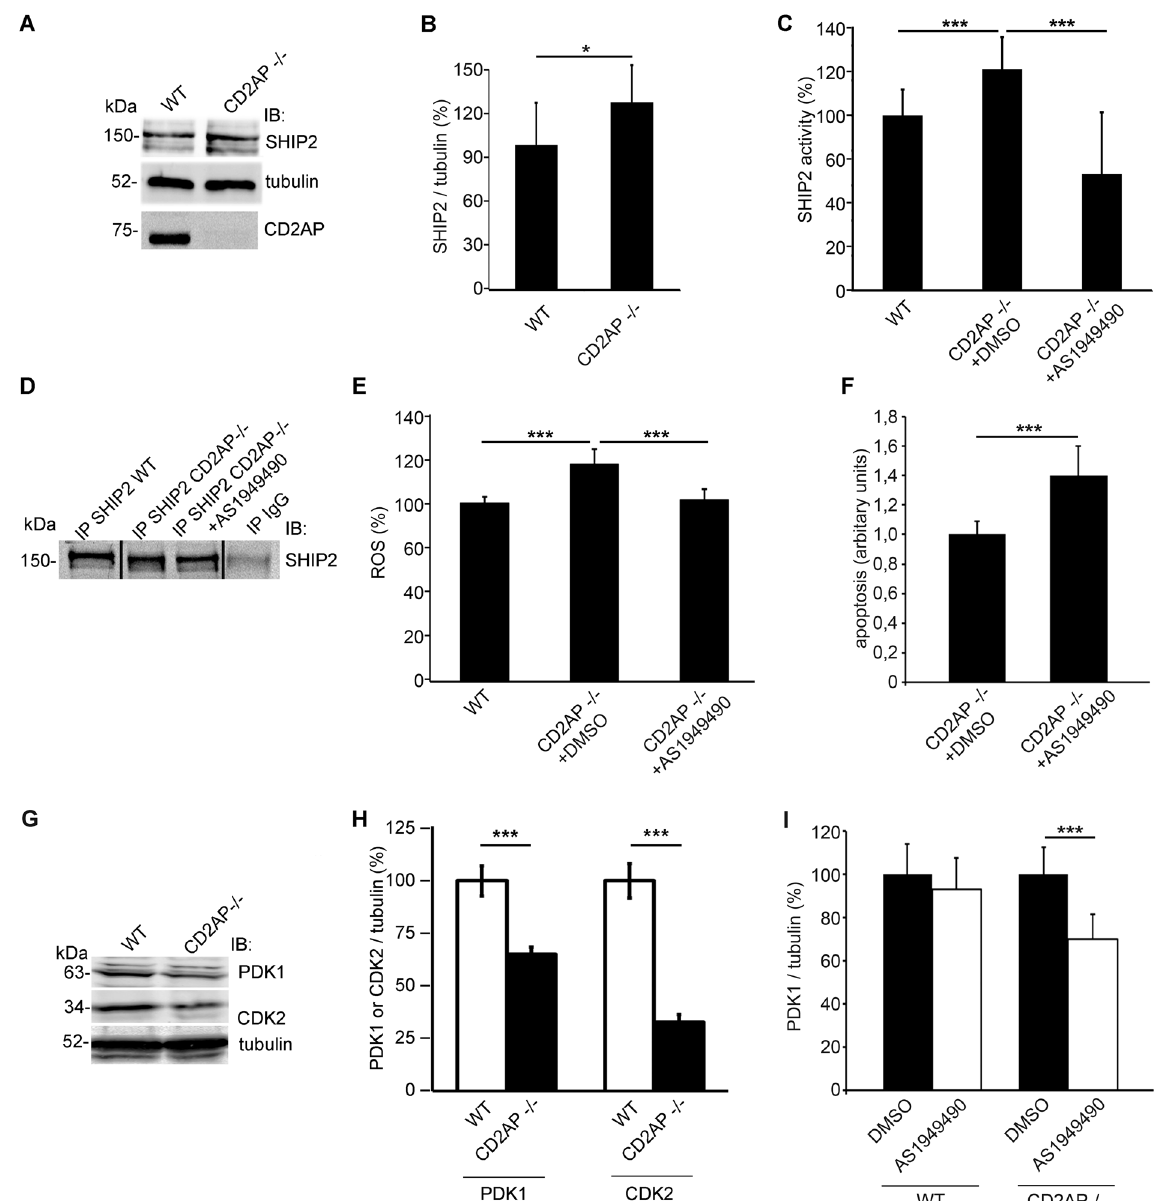
Figure 2. Inhibition of SHIP2 activity reduces ROS production in CD2AP knockout podocytes but does not protect from apoptosis. ( A ) Representative immunoblot for SHIP2 in wild type (WT) and CD2AP − / − podocytes. Tubulin is included as a loading control. ( B ) Quantification of SHIP2 expression level in WT and CD2AP − / − podocytes in three replicate blots as in ( A ) shows an increase in SHIP2 expression. Tubulin was used for normalisation. ( C ) SHIP2 activity is increased in the absence of CD2AP. Treatment of CD2AP − / − podocytes with SHIP2 inhibitor AS1949490 reduces SHIP2 activity. (D) Representative immunoblot for SHIP2 of immunoprecipitations carried out with SHIP2 IgG (IP SHIP2) or goat IgG (IP IgG) as a control from 500 µ g of protein lysates prepared from WT podocytes and CD2AP − / − podocytes treated or not with AS1949490. Similar immunoprecipitations were performed to enrich SHIP2 for activity assays. Full width blot is shown in Supplemental Fig. S1B. ( E ) Inhibition of SHIP2 prevents the increase in ROS generation induced by the absence of CD2AP, as observed by DCFH-DA fluorescent probe assay. Hoechst 33342 was used for normalization. ( F ) Flow cytometry with annexin V labelling indicates that AS1949490 treatment of CD2AP − / − podocytes induces apoptosis. ( G ) Representative immunoblot for PDK1 and CDK2 in WT and CD2AP − / − podocytes. Tubulin is included as a loading control. ( H ) Quantification of PDK1 and CDK2 in three replicate blots as in ( G ) in WT and CD2AP − / − podocytes shows a decrease in PDK1 and CDK2 expression in the absence of CD2AP. ( I ) SHIP2 inhibitor AS1949490 treatment reduces the expression of PDK1 in CD2AP − / − podocytes but not in WT podocytes. The experiments were performed three times with four ( A – D , F – I ) or 32 ( E ) replicates in each experiment. The bars show the mean expression in arbitrary units (error bars STDEV). * p < 0.05, *** p < 0.001, Student’s